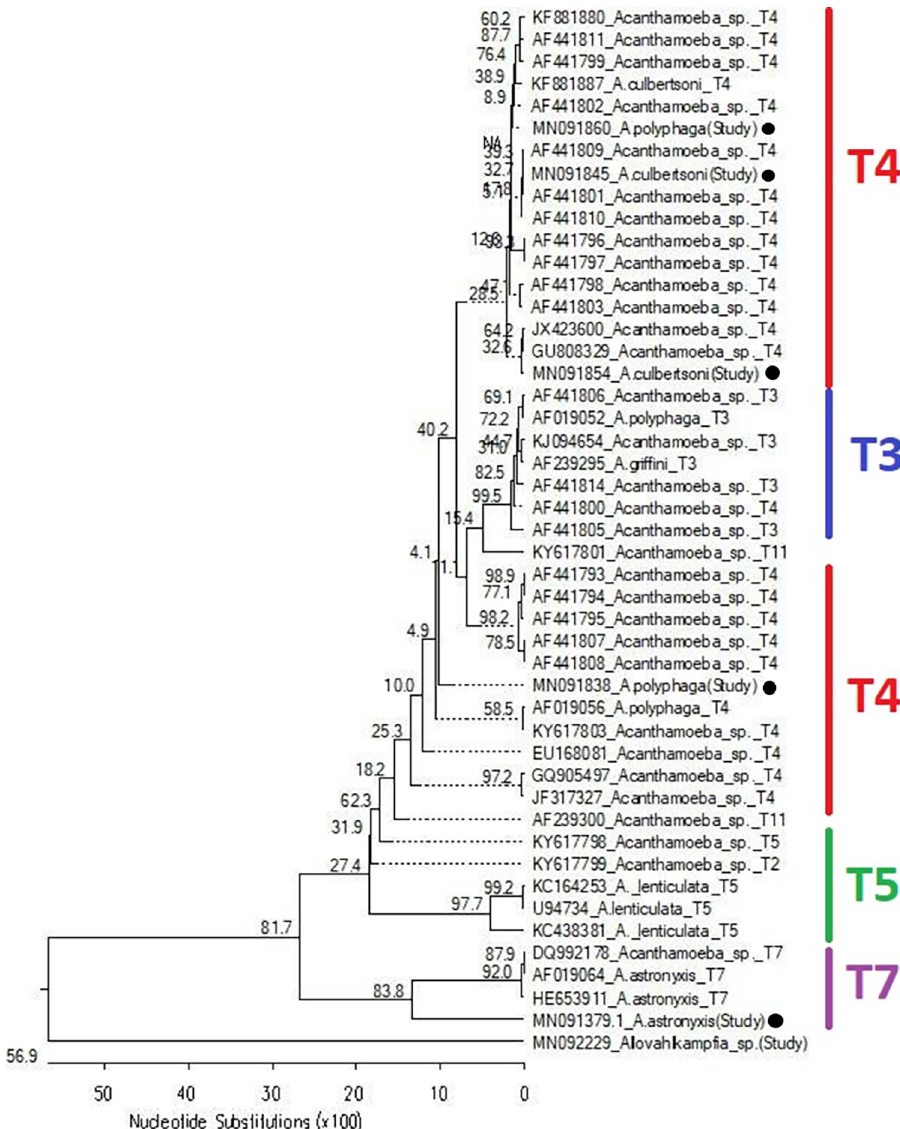
Fig 8. Phylogenetic tree showing the evolutionary relationship among the investigated isolates. Sequences with black circles are the ones analyzed in the current study. The scale below shows the number of substitutions in 100 nucleotides and corresponds to the branch length. Dashed branches indicate negative branches. The values at bifurcations show the node support value in the 1000 bootstrap trials. NA indicates the absence of bootstrapping for the respective